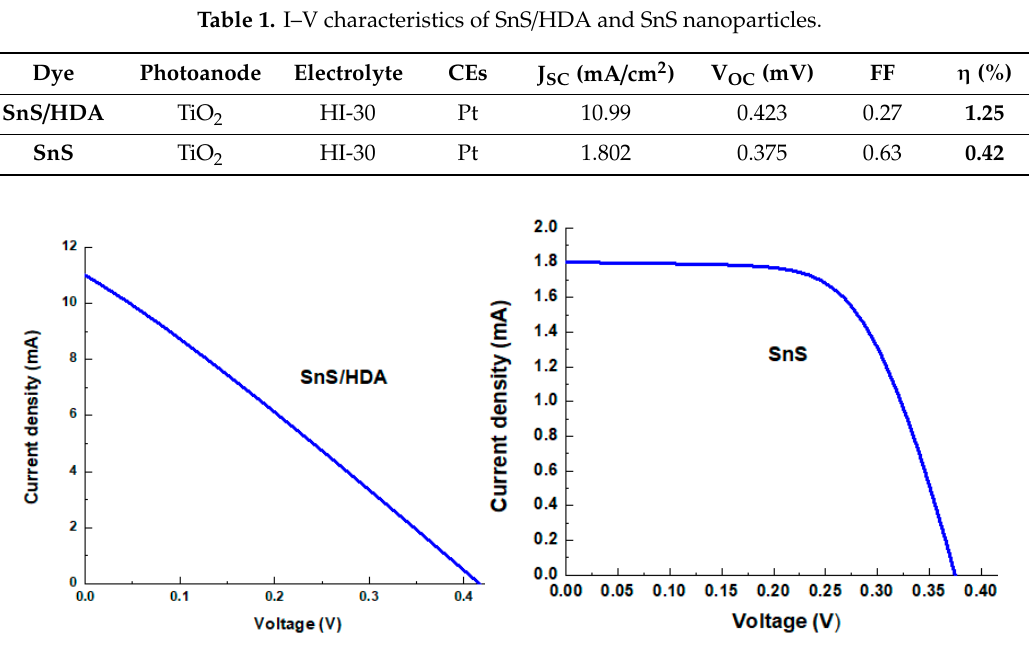
Figure 6. I–V curve characteristics of SnS/HDA and SnS nanoparticles.